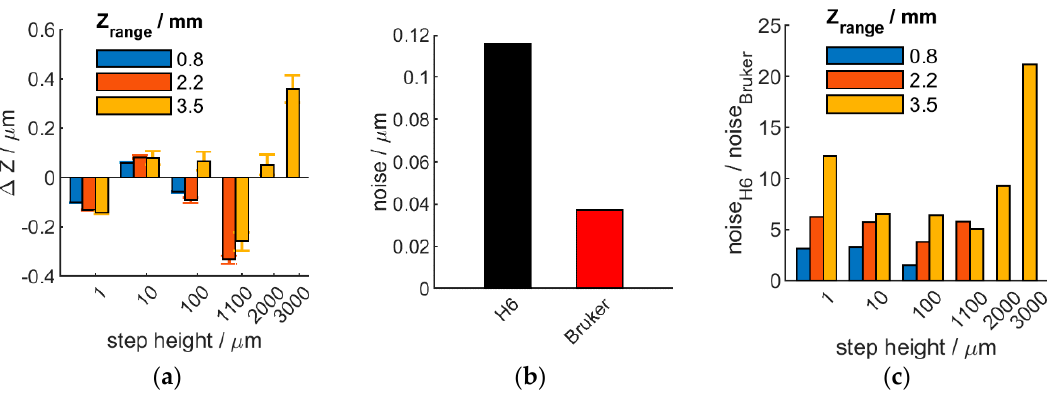
Figure 3. Comparative measurements of measured step-height difference ( a ), noise level, with single-sided positive error bar indicating standard deviation ( b ) and relative noise ( c ) between Heliotis H6 and Bruker NPFLEX, both evaluating the same step-height with similar field-of-view optics. Z scan rage (in a and c ): 0.83 mm (blue), 2.16 mm (red), 3.49 mm (yellow).